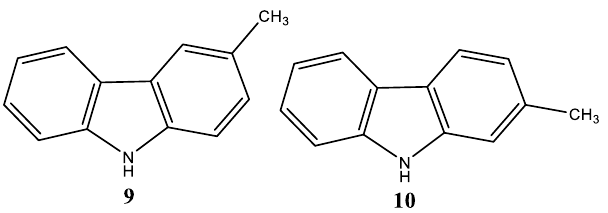
Figure 4. Structures of 3-methylcarbazole ( 9 ) and 2-methylcarbazole ( 10